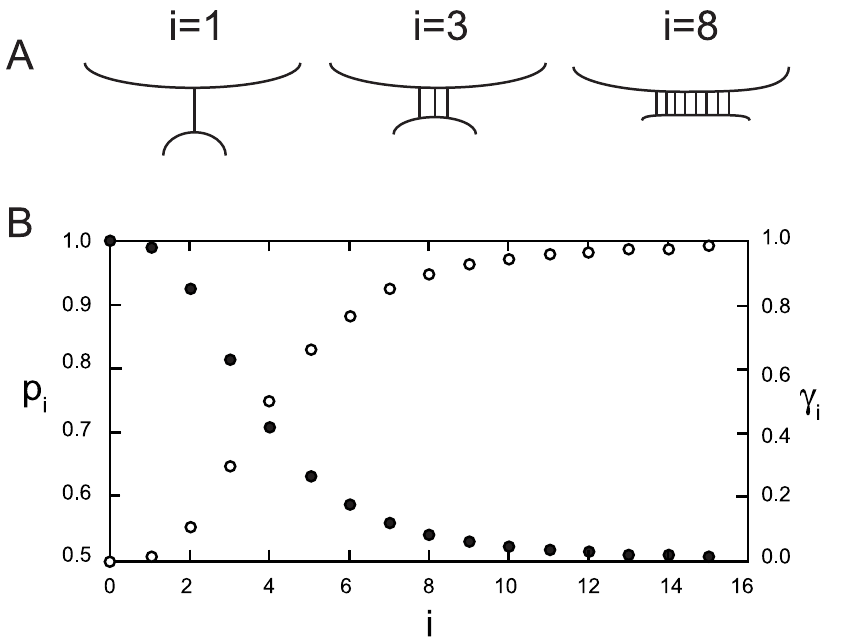
Figure 6. An example of how the probability p i of disabling a bond when there are i bonds present might depend on i . A. Because of the repulsive forces between membranes, when a single bond bridges two membranes it will be stretched further than a bond that is one of many holding the membranes together. B. In this example the probability of breaking a bond in the presence of a large number of other bonds p b ~ 0 : 5 , p